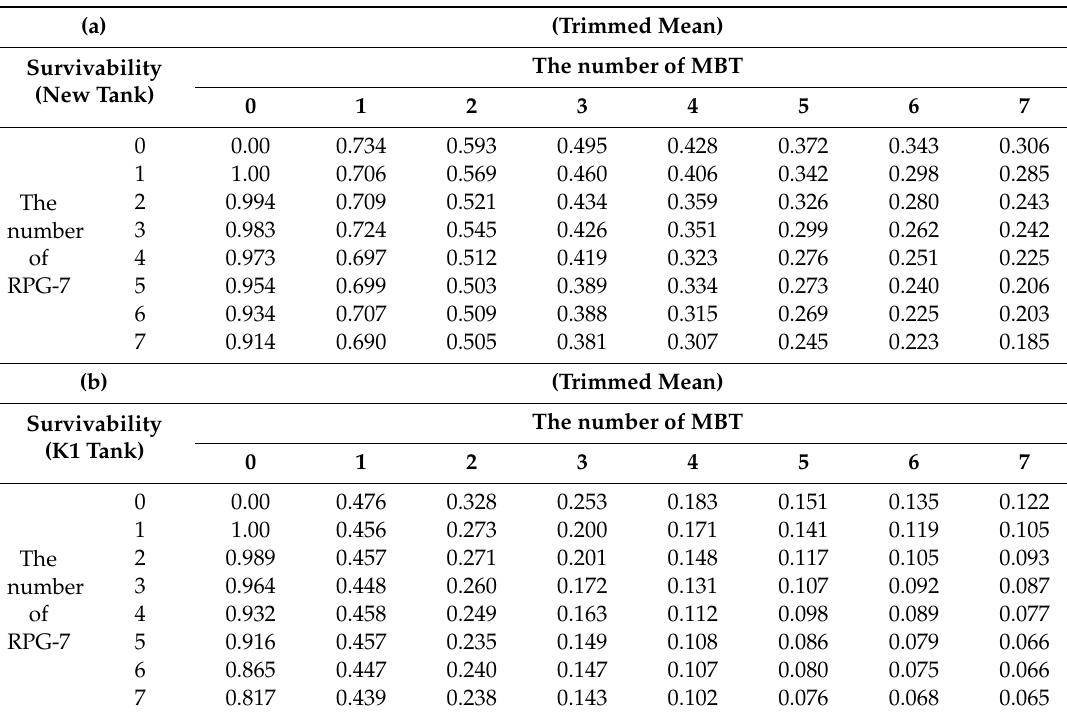
Table A4. Tables showing the survivability of K1 and the new tanks with increasing number of enemy anti-tank guns and MBTs (a) Survivability of K1 tank model (b) Survivability of the new tank